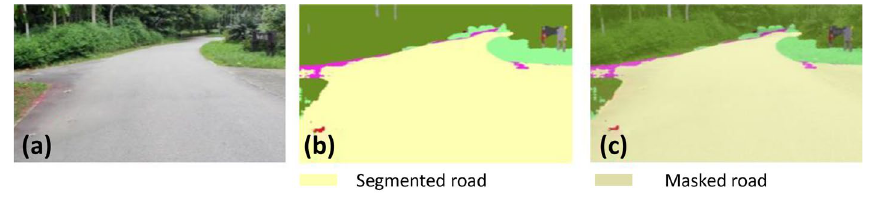
Figure 25. Online results: road.